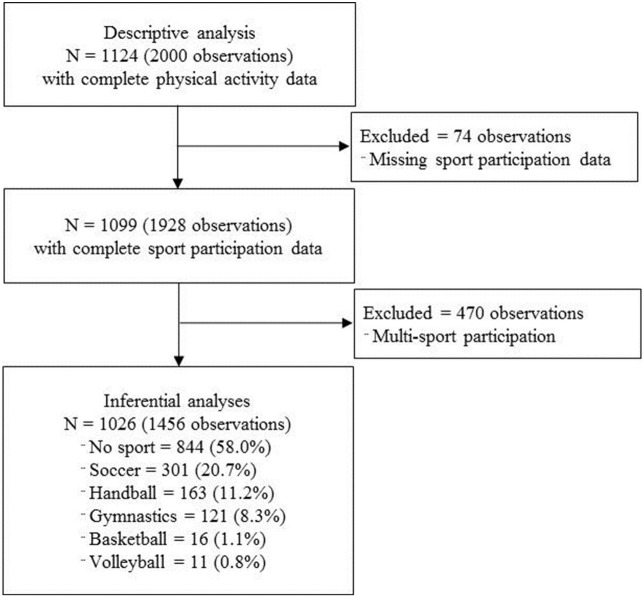
Study flow diagram.